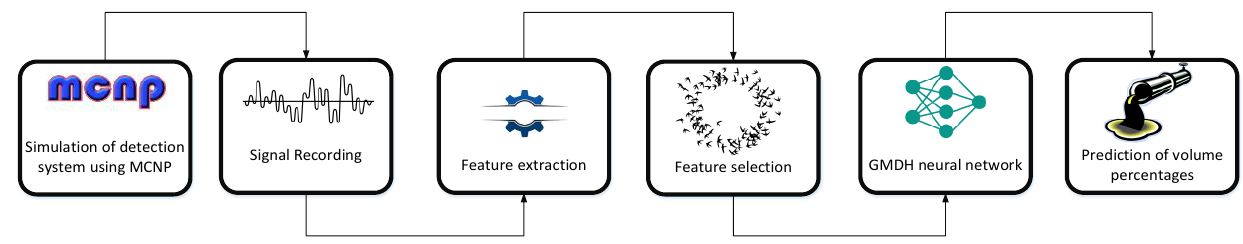
Figure 1. Flowchart of the general implementation process of the proposed research.